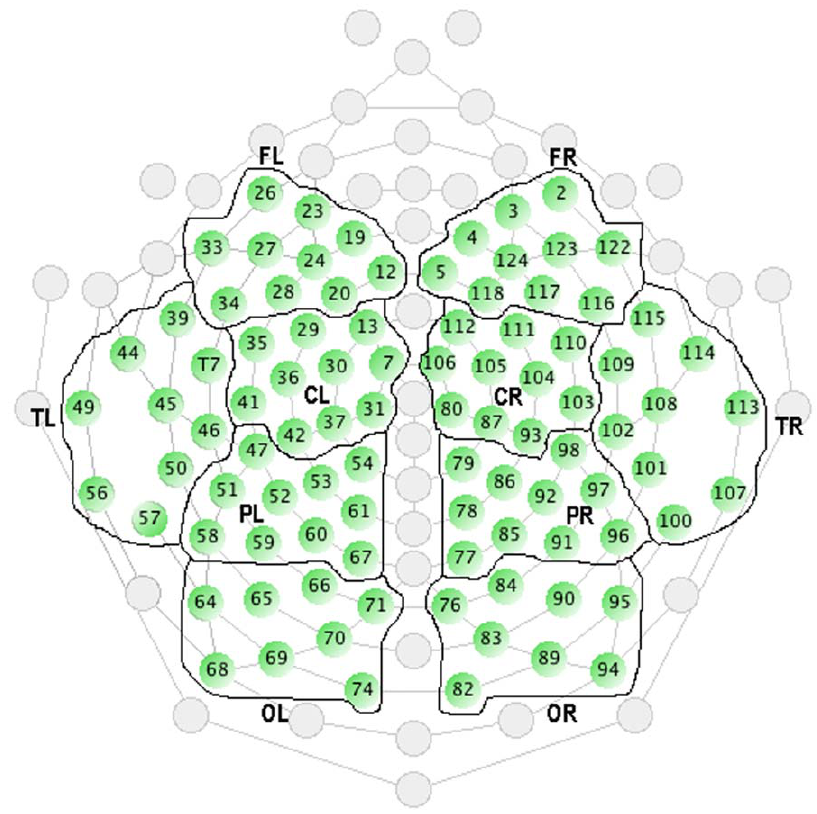
Figure 1. Included Electrodes by Cortical Area. Note: FL=Front Left, FR=Front Right, CL=Central Left, CR=Central Right, TL=Temporal Left, TR=Temporal Right, PL=Parietal Left, PR=Parietal Right, OL=Occipital Left, OR=Occipital Right.